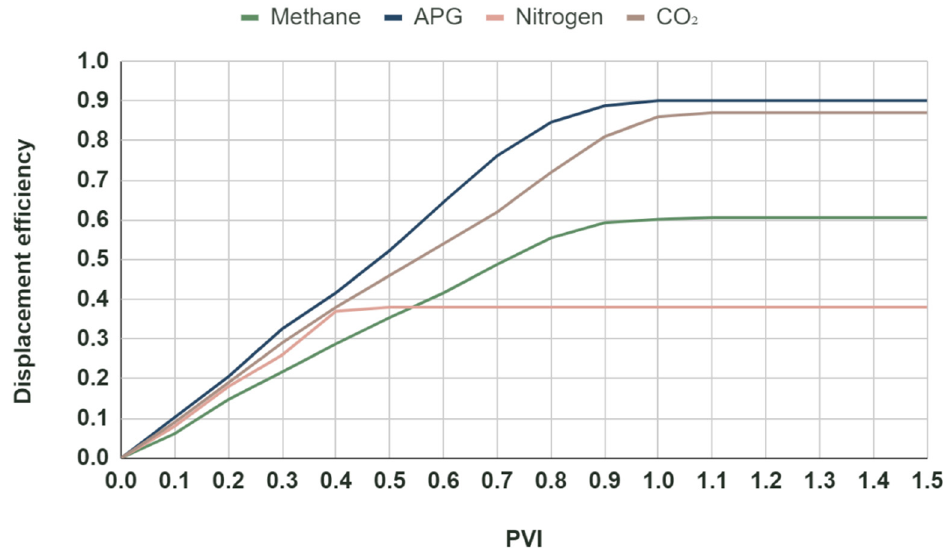
Figure 4. Displacement dynamics for various injection gases at a pressure of 40